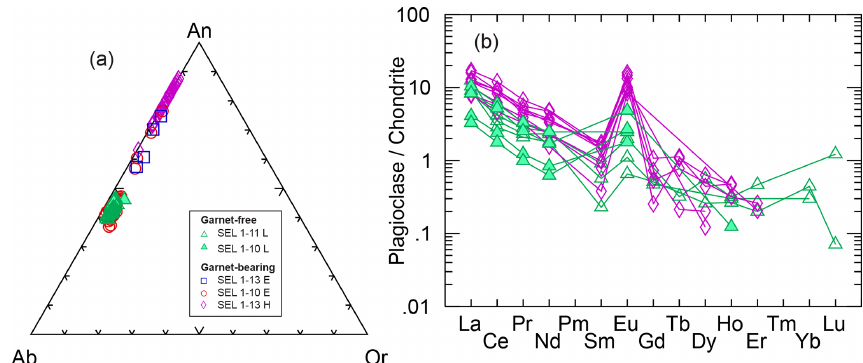
Figure 6. Major and trace element variation in plagioclase. (a) Plagioclase compositions showing that the samples 13E and 13H are signif- icantly more calcic than the two garnet-free samples and sample 10E. (b) Chondrite-normalised REE plot (normalisation values of Sun and McDonough,